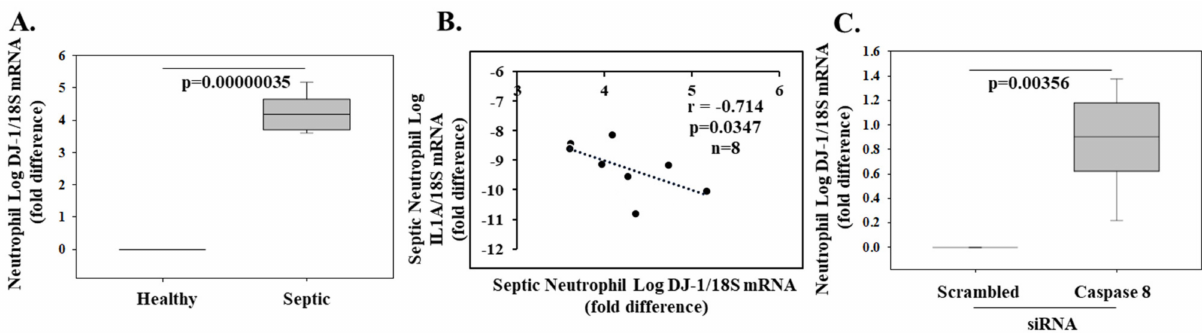
Figure 2. Polymorphonuclear cell DJ-1 expression is increased in septic patients and inversely correlates with the in- flammatory cytokine ILA. Neutrophil RNA was isolated from healthy controls ( n = 3) and septic patients ( n = 8) using TRIzol reagent and reverse transcribed into cDNA. DJ-1, IL1A, and 18S (housekeeping) gene expression was determined by real-time quantitative (RT-PCR). The Human Ethics Review Committee of St. Michael’s Hospital reviewed and approved the ‘inflammation in trauma and sepsis’ (INSIST) study protocol for collecting blood from healthy volunteers and septic patients. Written informed consent was obtained from patients or a surrogate decision-maker. DJ-1/18S and 1L1A/18S mRNA expression in septic neutrophils was calculated as a log-fold change over healthy controls and presented as box plots showing the median and interquartile range ( A ). Negative correlation between pro-inflammatory IL1A and DJ-1 ( B ). Human septic neutrophils were transfected with a scrambled (control) or a caspase 8 (apical caspase in the extrinsic cell death pathway) siRNA for 24 h ( C